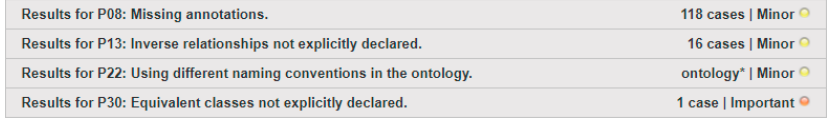
Figure 12. Reevaluation result after reparation activity.